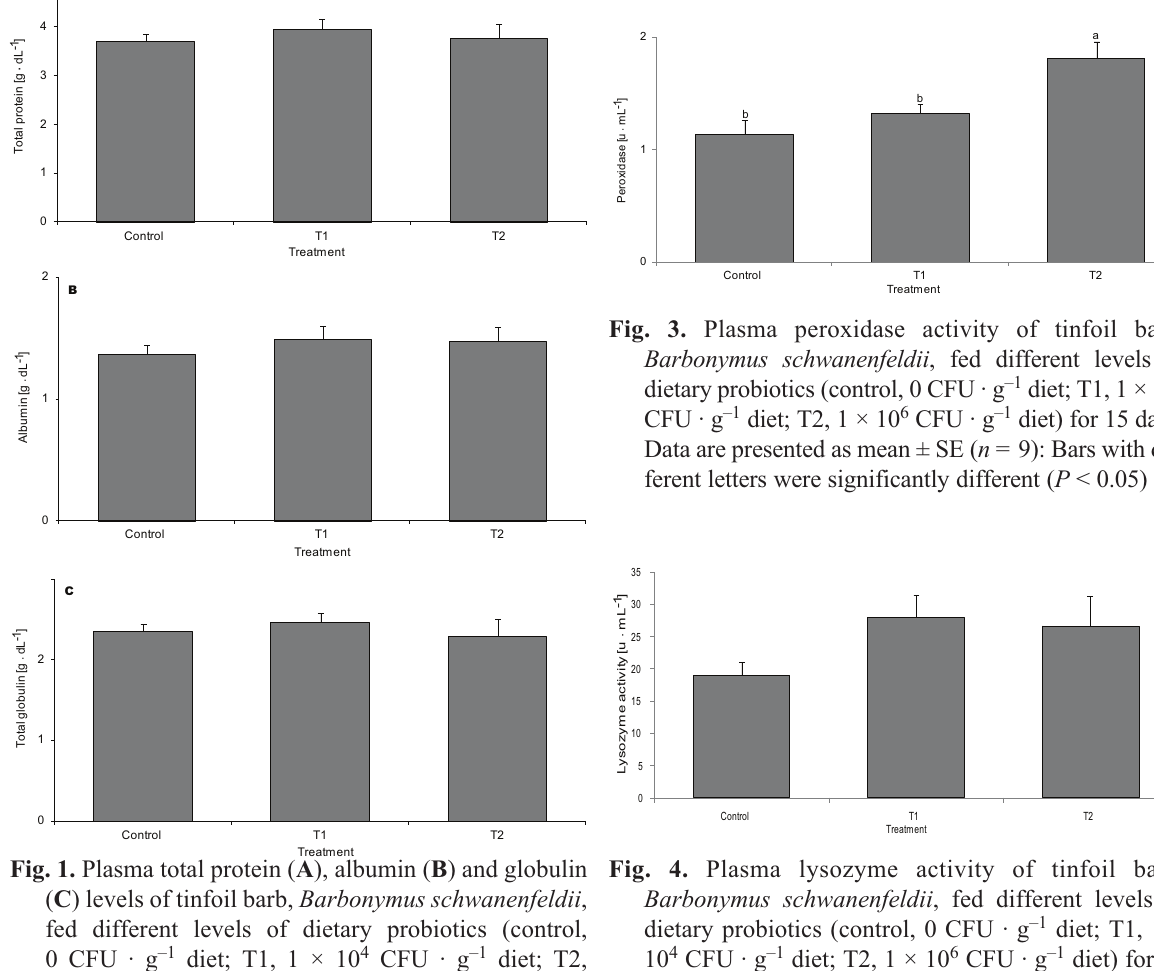
Fig. 1. Plasma total protein ( A ), albumin ( B ) and globulin ( C ) levels of tinfoil barb, Barbonymus schwanenfeldii , fed different levels of dietary probiotics (control, 0 CFU · g –1 diet; T1, 1 × 10 4 CFU · g –1 diet; T2,